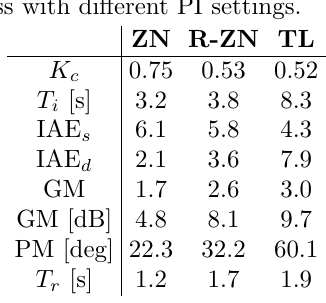
Table 3: Controller settings and performance and ro- bustness measures for simulated control sys- tem for ”time-constant plus time-delay” pro- cess with different PI settings.